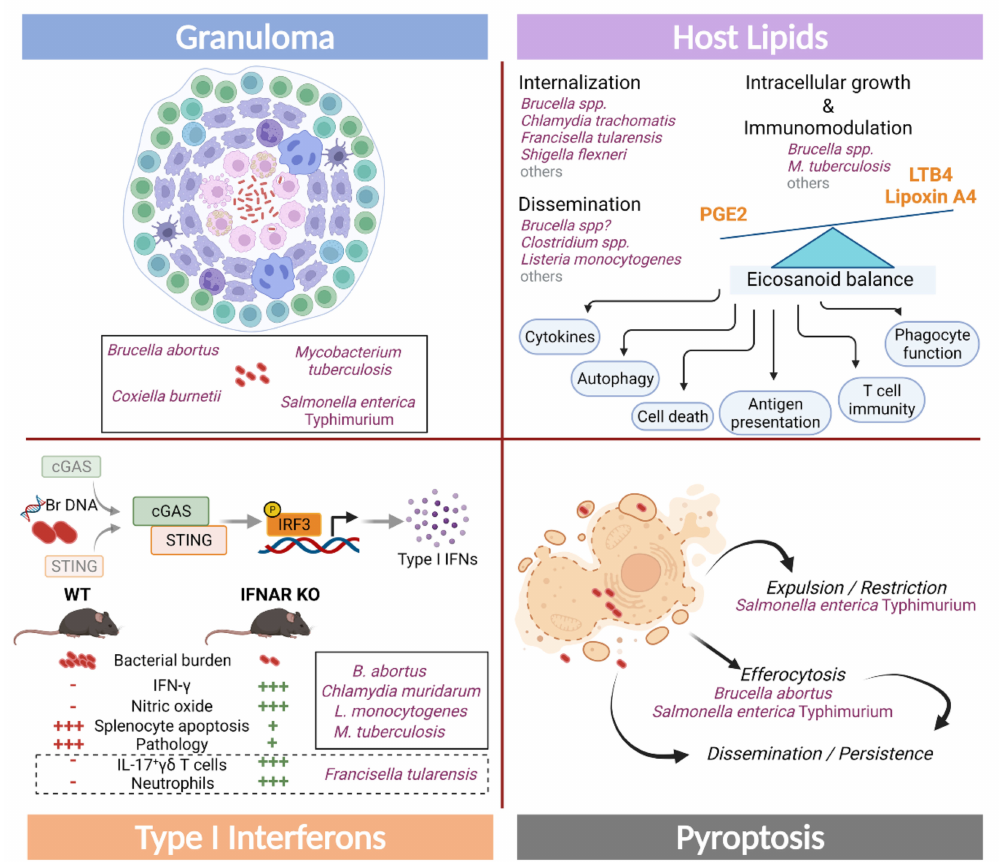
Figure 2. Shared strategies by intracellular pathogenic bacteria during chronic infections. Granu- lomas are focal aggregates of heterogeneous macrophages together with other immune cells at the infection site that form a physical barrier for escaping immune surveillance, but also offer a bene- ficial microenvironment for the bacteria (red rod), including Brucella , to remain viable for decades. The enriched anti-inflammatory milieu and the limitation of the positioning of effector immune cells provide a safe niche, and the constant movement of cells gives the opportunity for secondary infections. Interaction and use of host lipids by pathogenic bacteria play a central role for internal- ization, dissemination, intracellular growth and immunomodulation during chronic infection. The relative balance of eicosanoids modulates key processes, shown in blue boxes, and is essential for determining the pathogenesis and development of a proper anti-bacterial immunity. The role of type I interferons during bacterial infections is highly context-dependent with both beneficial and detrimental outcomes for the host. In infected macrophages, IRF3-mediated type I IFN production is promoted by c-GAS-STING recognition of Brucella DNA. IFNAR-deficient murine models of chronic infection have shown reduced bacterial burden and pathology, correlating with enhanced IFN- γ and nitric oxide production and diminished splenocyte apoptosis. Type I IFNs have been related to inhibit IL-17 + γδ T cells and neutrophil expansion in Francisella tularensis -infected mice. The outcome of caspase-1/inflammasome-induced pyroptotic cell death is also highly dependent on timing and cell type. Pyroptotic intestinal epithelial cells are expelled into the lumen restricting Salmonella dissemination and replication. In contrast, efferocytosis of Salmonella or Brucella entrapped in py- roptotic macrophages shields the bacteria from the neutrophil respiratory burst, contributing to their